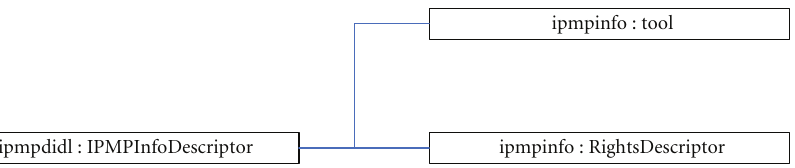
Figure 3: Schematic view of the structure of the ipmpdidl : IPMPInfoDescriptor element.